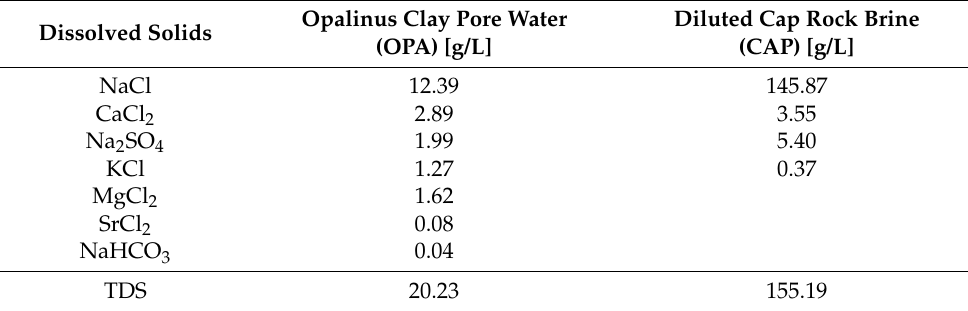
Table 2. Chemical composition of the Opalinus clay pore water (OPA) and the diluted cap rock brine (CAP) [12]. TDS = total dissolved